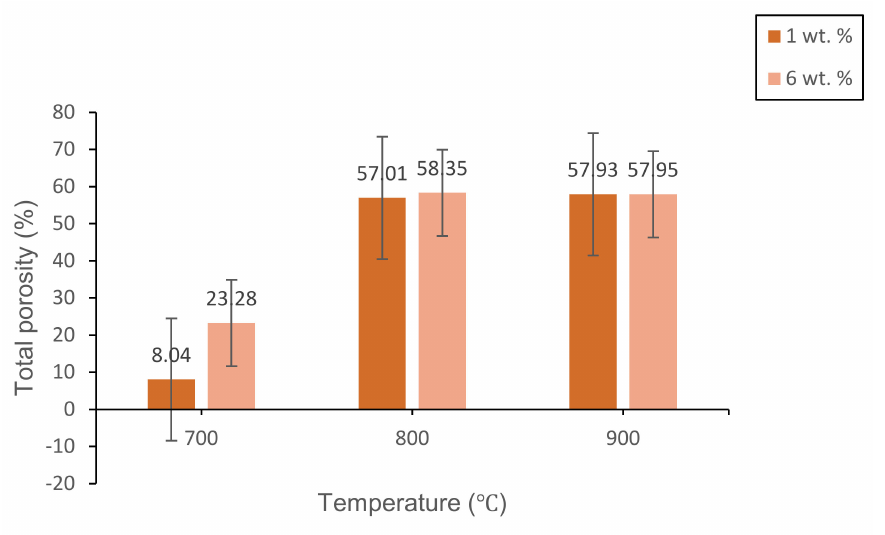
Figure 11. The total porosity of 1 and 6 wt% samples sintered at various temperatures for 60